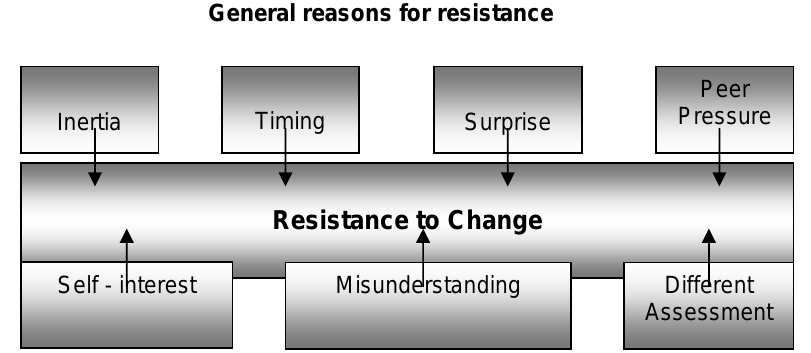
Figure 3: Resistance to